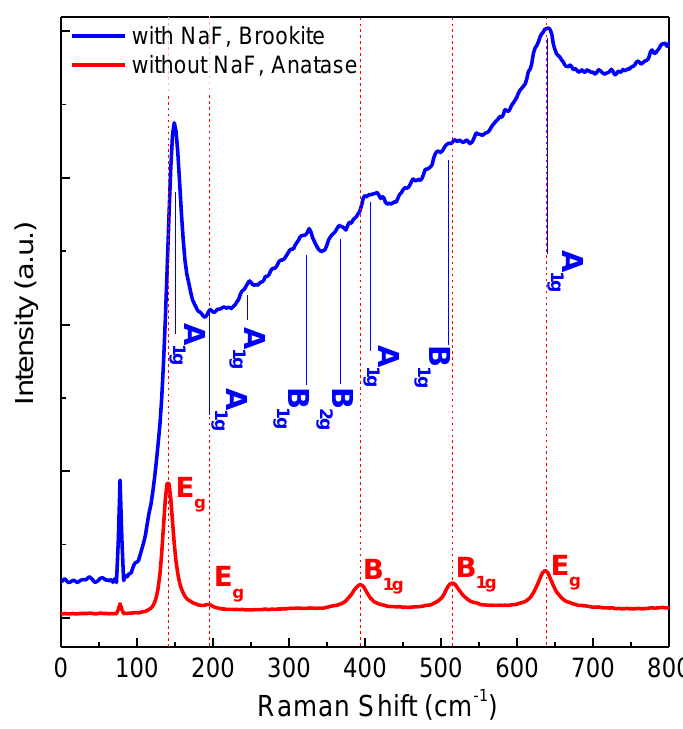
Figure 3. Raman spectra for the grown brookite (blue) and anatase (red) samples. The anatase Raman reflections are further clarified by vertical dashed red lines.